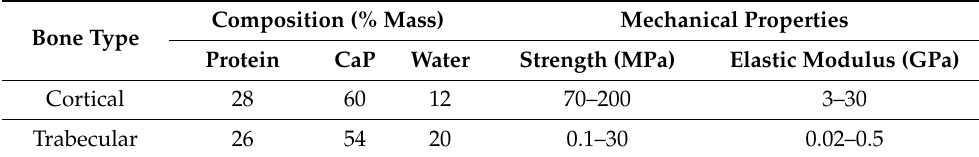
Table 1. Bone composition and mechanical properties. Reproduced with permission from [24].